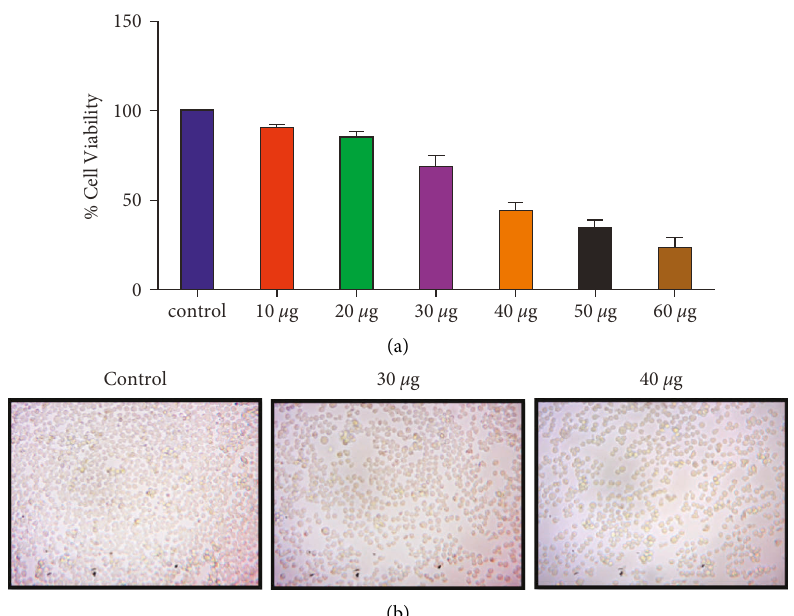
Figure 6: CTCANc exhibited cytotoxicity in MOLT4 cells. The viability of MOLT4 cells was determined using the MTTassay using various doses (10 − 60 μ g/ml) of nanocomposites, and the mean ± SD of three independent experiments is reported (a). Representative images (20X) for the triplicate set of studies are shown (b).